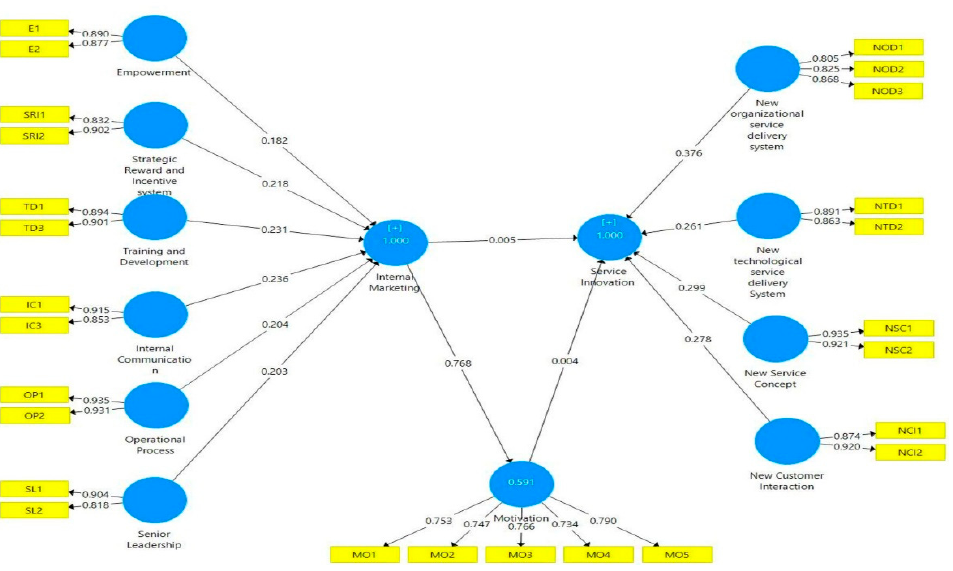
Figure 2. A higher-order multicomponent research model. Source: Adapted from (Henseler et al. 2009).